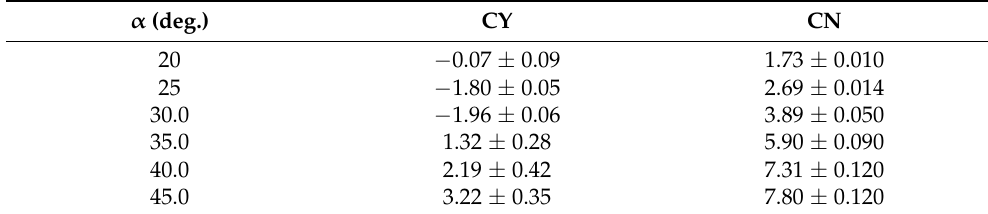
Table 3. Side and normal force coefficients versus angle of attack: Ma = 0.2, Re = 2 × 10 6 . Grid U1. α (deg.)